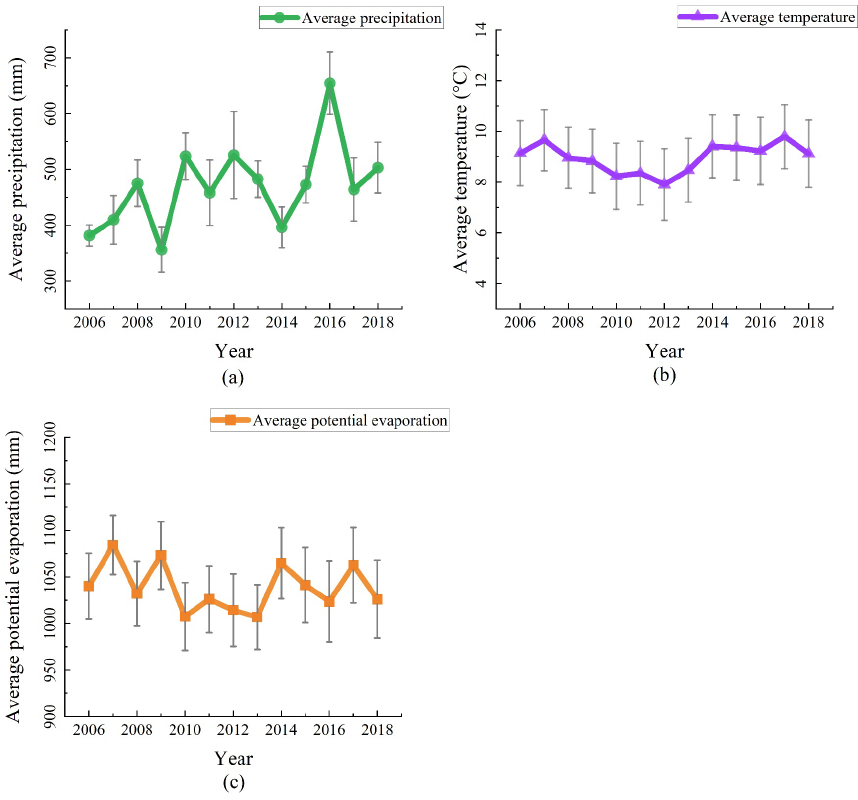
Figure 5. Annual change of climate factors. ( a ), ( b ) and ( c ) were the annual average precipitation, temperature and potential evaporation, respectively.